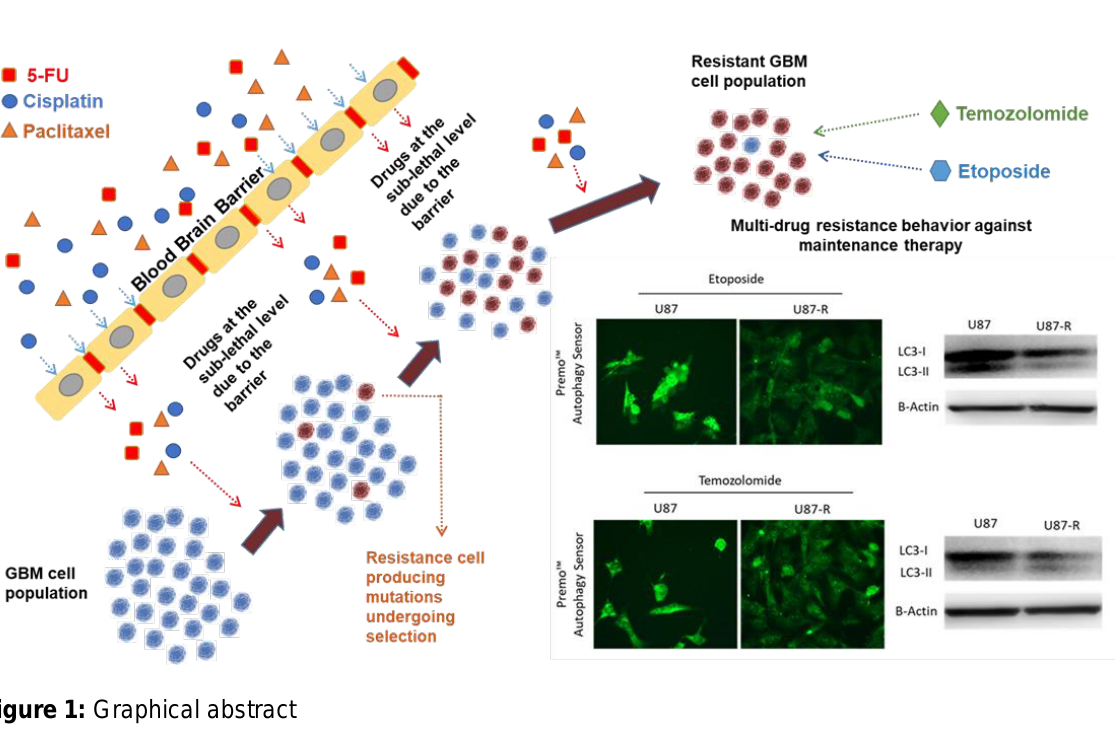
Figure 1: Graphical